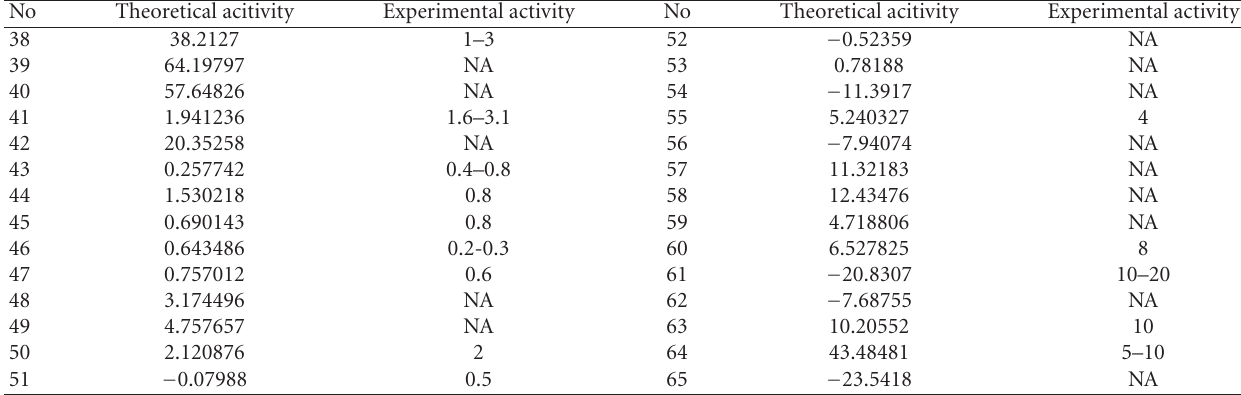
Table 5: Comparison of experimental and theoretical the activity by using the multiple regression analysis for compounds in Skeleton III.